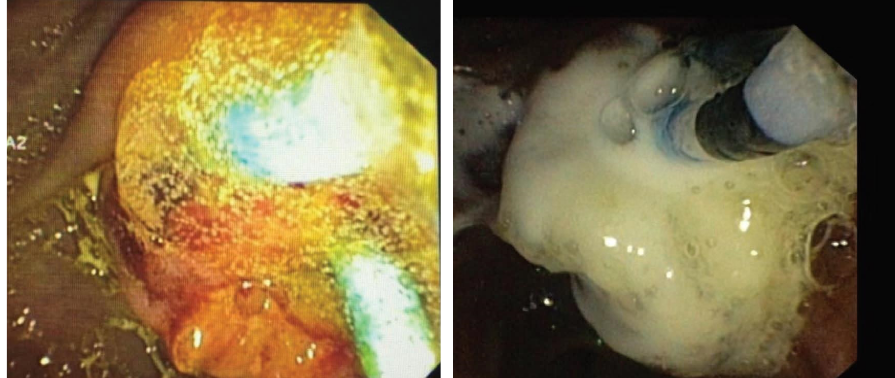
Figure 3: Images of purastat and beriplast injection to the papilla vater